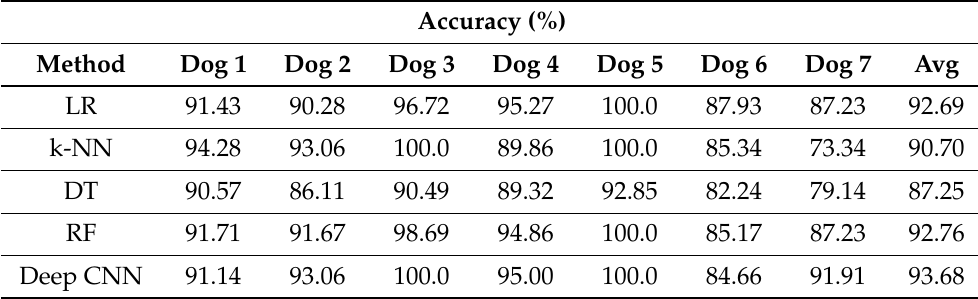
Table 6. Per dog accuracy of each Machine Learning (ML) model on dog activity recognition